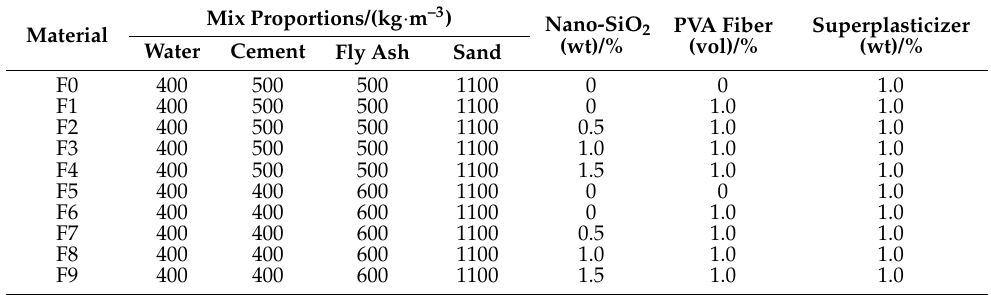
Table 4. Mix ratio of high-volume fly ash mortar.